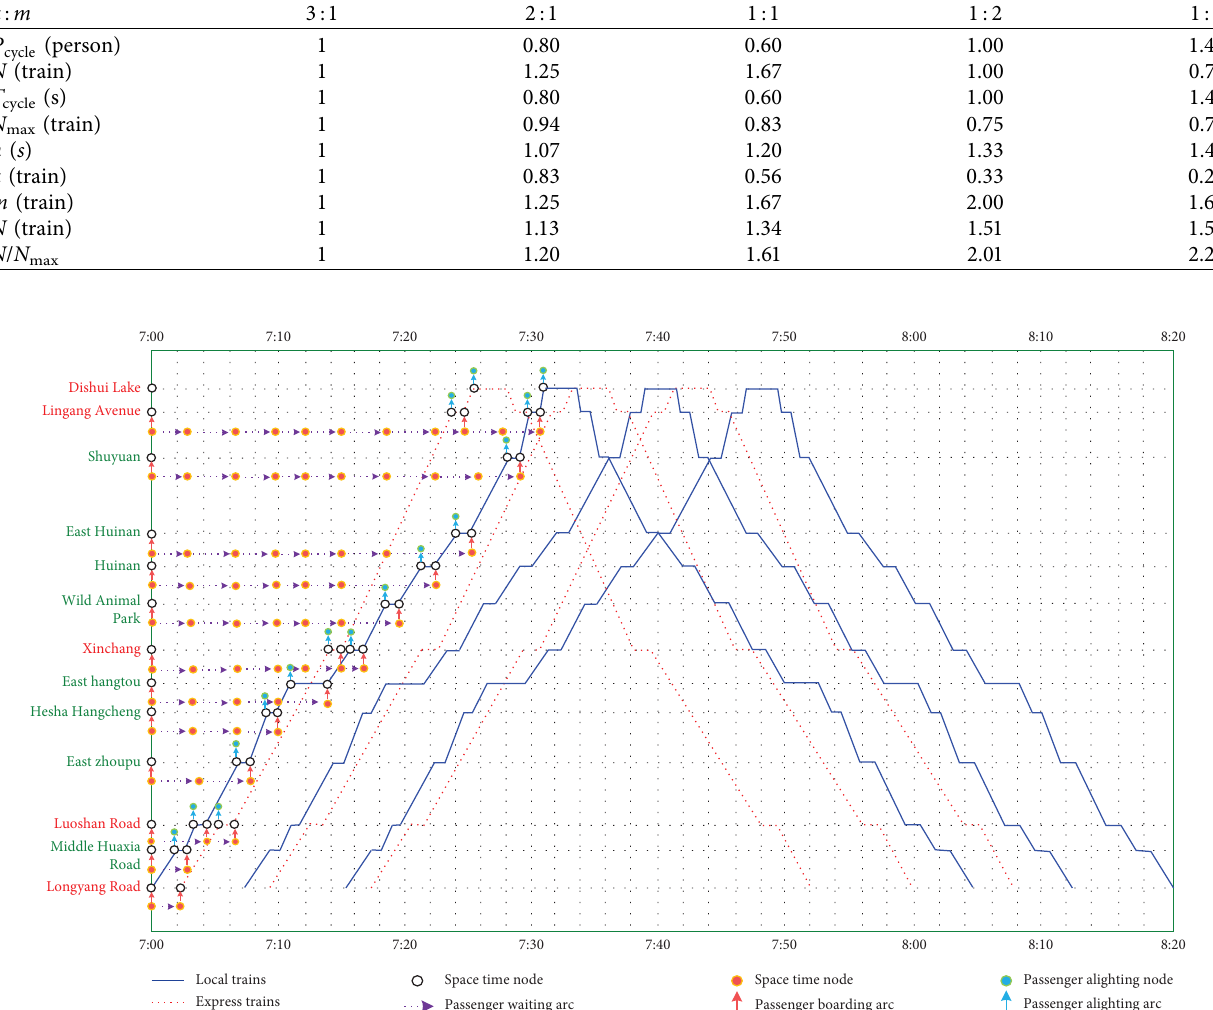
Table 5: Normalization of line index data under the proportion of express and local mode.